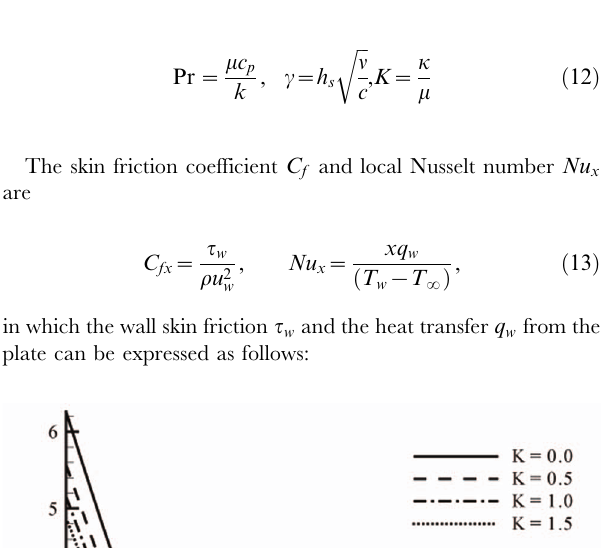
Figure 3. Influence of K on microrotation profile g ( g ) when n ~ 0 : 5 :